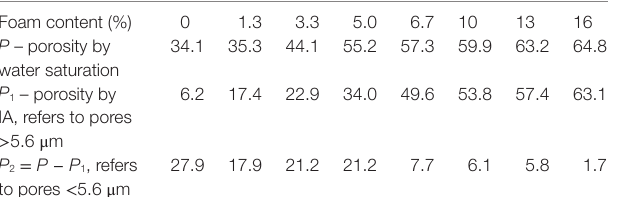
Table 3 | Porosity by water saturation and pore volumetric proportion by